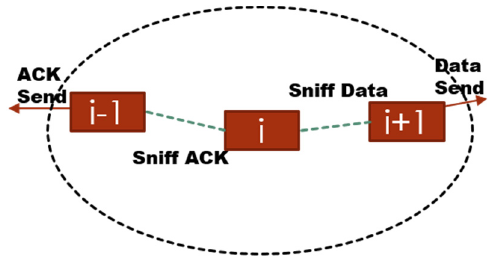
Figure 8. Neighbour monitoring process.